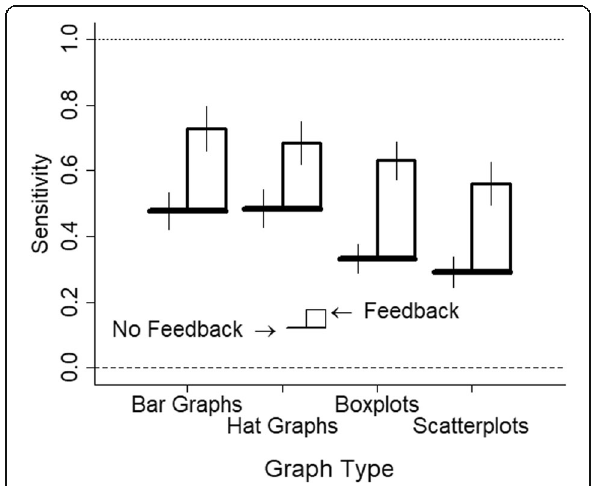
Fig. 18 Sensitivity is potted as a function of graph type and whether there was no feedback (experiment 4) or there was feedback (experiment 5). Sensitivity is measured as the slope. Higher scores indicate better sensitivity. Scores of 1 indicate perfect sensitivity and scores of 0 indicate no sensitivity. The brims correspond to the no-feedback conditions and the crowns correspond to the feedback conditions. Error bars are ±1 SEM calculated from separate linear mixed